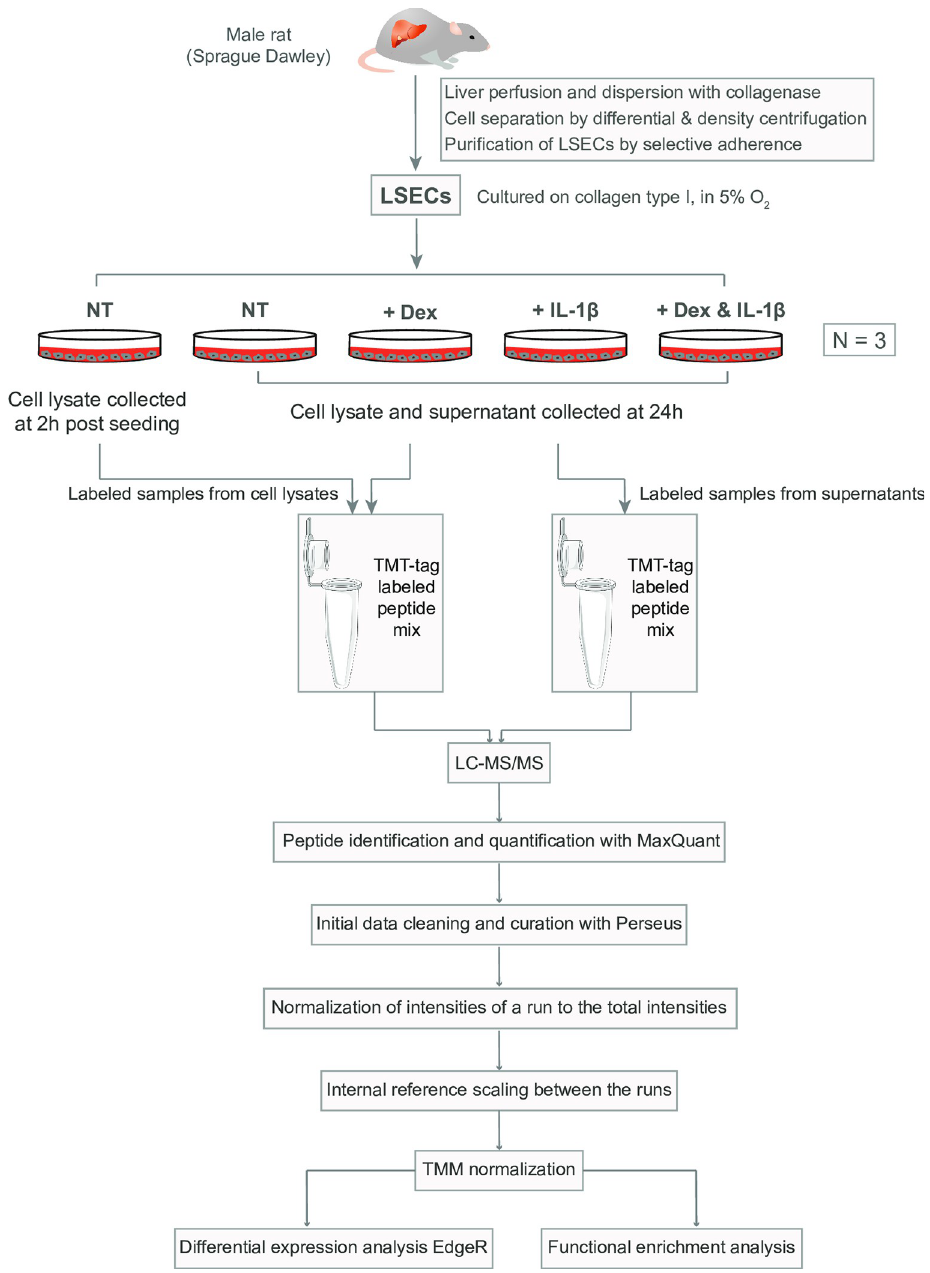
Fig 1. Overview of the experimental setup for the TMT proteomics study. The figure shows the experimental setup for the quantitative proteomics experiment. The whole experiment was repeated three times with cells from different rats. Each biological replicate included pooled LSECs from 2 rat livers. The dose of Dex was 1 μ g/ml [38]. The dose of IL-1 β was 100 U/ml, which was chosen after testing the effect of different doses on IL-6 production in LSECs in an ELISA assay (S1 Fig). NT: not treated with Dex, or IL-1 β . was normalized for compositional bias using edgeR TMM normalization (Bioconductor [45]). These normalized intensities were then used in differential protein expression analysis using the edgeR-limma workflow [46].